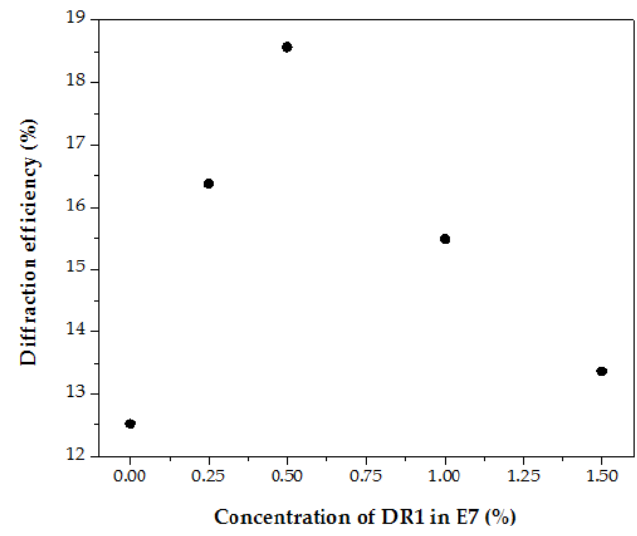
Figure 4. Diffraction efficiency of the first-order diffraction as a function of the concentration of azo Figure 4. Di ff raction e ffi ciency of the first-order di ff raction as a function of the concentration of azo dye. The devices are operated under an applied voltage of 5.0 V. dye. The devices are operated under an applied voltage of 5.0 V. Table 1. Diffraction efficiencies and the corresponding differences of refractive indices in samples Table 1. Di ff raction e ffi ciencies and the corresponding di ff erences of refractive indices in samples with with various dye concentrations. various dye